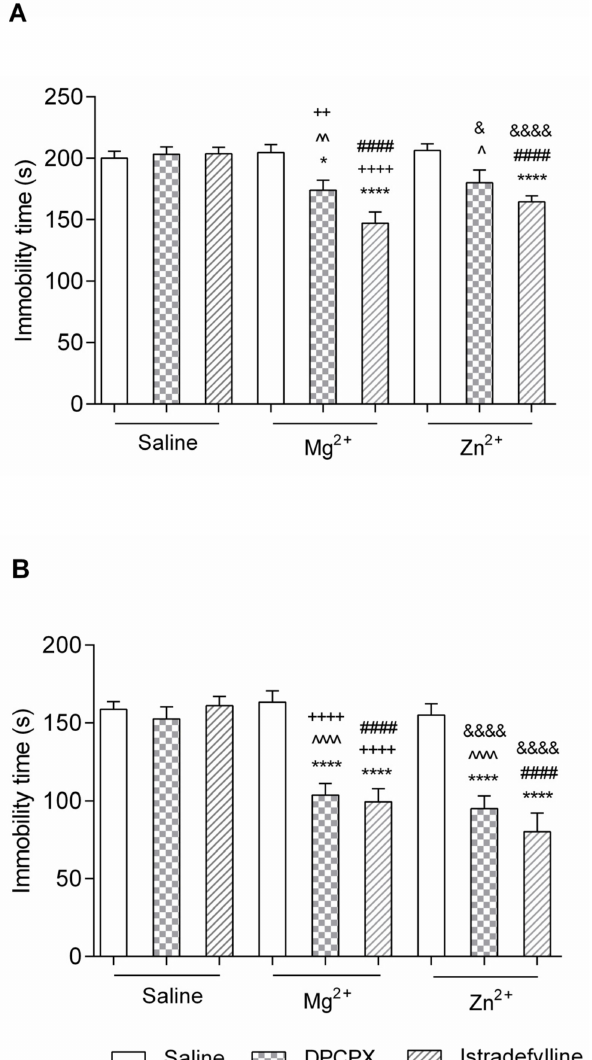
Figure 1. Effect of co-administration of DPCPX and istradefylline with Mg 2+ and Zn 2+ in the ( A ) FST and ( B ) TST in mice. DPCPX, Mg 2+ and saline were administered i.p. 30 min, whereas istradefylline p.o. and Zn 2+ i.p. 60 min prior behavioural testing. The data are presented as the means ± SEM. Each experimental group consisted of 10 animals. ( A ) * p < 0.05, **** p < 0.0001 vs. NaCl-treated group; ˆ p < 0.05, ˆˆ p < 0.01 vs. DPCPX-treated group; #### p < 0.0001 vs. istradefylline-treated group; ++ p < 0.01 vs. Mg 2+ -treated group; & p < 0.05, &&&& p < 0.0001 vs. Zn 2+ -treated group (two-way ANOVA followed by Bonferroni’s post hoc test); ( B ) **** p < 0.0001 vs. NaCl-treated group; ˆˆˆˆ p < 0.0001 vs. DPCPX-treated group; #### p < 0.0001 vs. istradefylline-treated